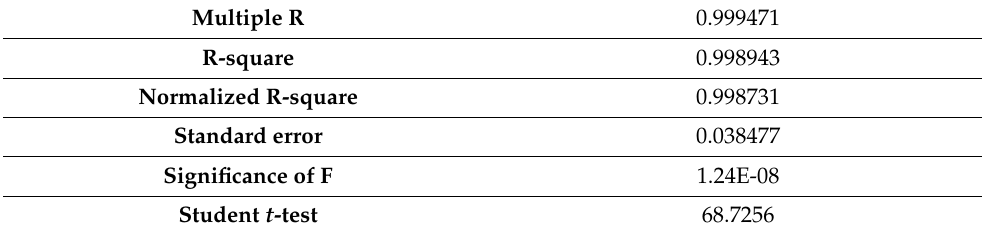
Table 5. Correlation and regression analysis of the maximum content of TSP and asphaltene.